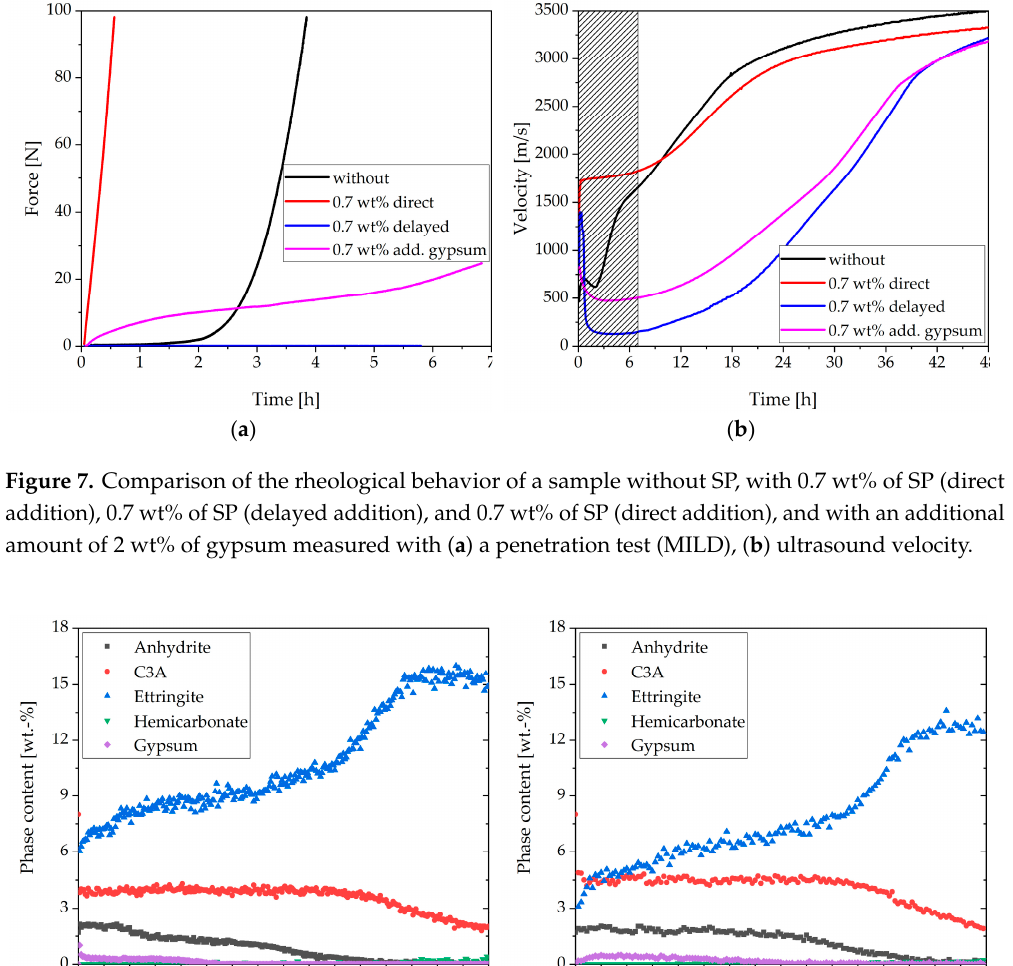
Figure 9. Average brownmillerite content during the first 2 h at the beginning of hydration (t 0 ), without SP, with direct addition of 0.7 wt% of SP, with a delayed addition of 0.7 wt% of SP, and with 2 wt% additional gypsum and direct addition of 0.7 wt% of SP . Figure 10a summarizes the C 3 A content of the different samples examined in this study. It could be seen that after the initial fast reaction, the amount of C 3 A in the sample without SP was the highest. In the system with delayed addition of SP, as well as additional gypsum and direct addition, lower C 3 A amounts could be detected, and hence a higher dissolution of C 3 A within the first minutes could be assumed. However, the lowest aluminate content after the initial reaction could be detected in the sample with 0.7 wt% of SP (direct addition). Figure 10b presents the ettringite contents of the different systems. The sample with 0.7 wt% (direct addition) reached the maximum amount of ettringite (12.6 wt%) at the beginning of cement hydration. The sample without SP reached the same amount after 27 h, and the sample with a delayed addition after 39 h. The first two samples decreased slowly after 27 h. The ettringite content of the sample with additional gypsum was lower than the sample with a